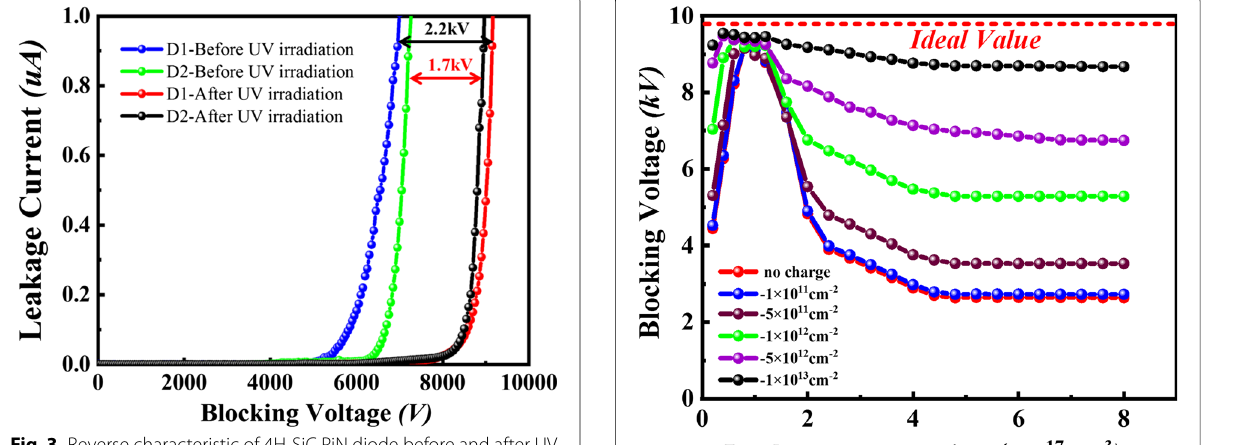
Fig. 3 Reverse characteristic of 4H-SiC PiN diode before and after UV irradiation